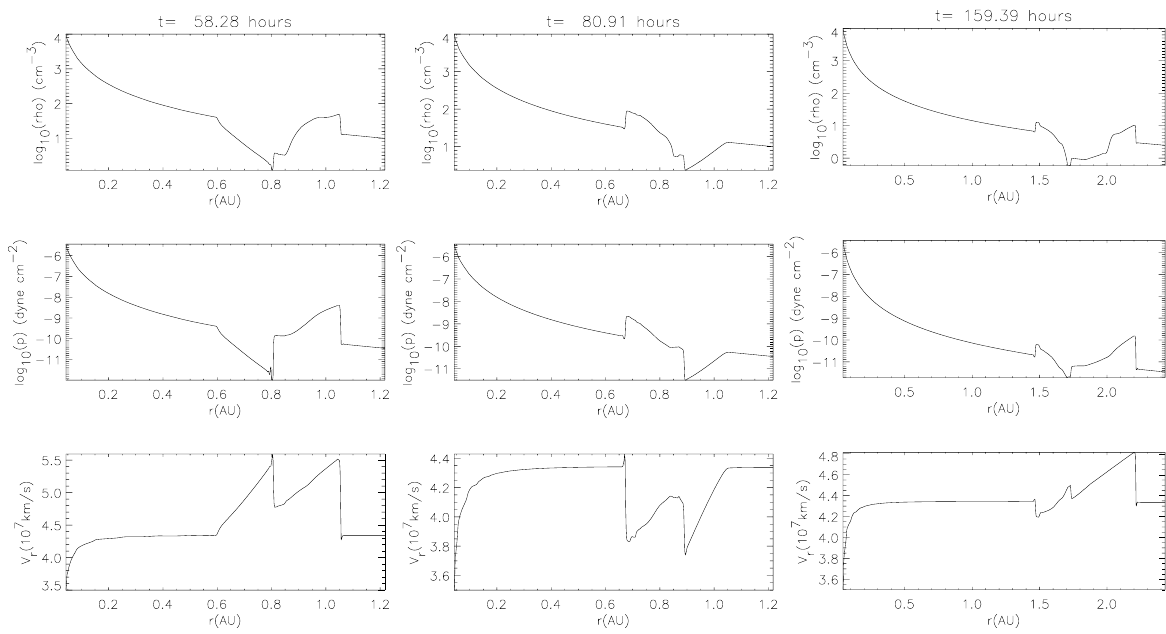
Fig. 1. Results from one-dimensional hydrodynamic ICME models. In Figs. 1a and 1b, results are shown when the ICME has reached approximately 1AU (after 58 and 81h, respectively), and in Fig. 1c when it is approaching 2AU (after 159h). In each case, the three panels show the density, pressure and radial velocity. The Fig. 1a (1b) case shows that the initial ICME speed is a factor of two bigger (smaller) than the solar wind speed, but the initial ICME density and pressure are the same as the solar wind. In Fig. 1c, the initial ICME pressure is a factor of 10 larger than that in the solar wind, but the density and radial velocity are the